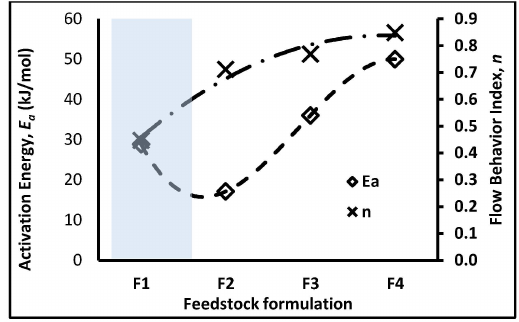
Figure 8. Determination of critical feedstock formulation between E a and n .